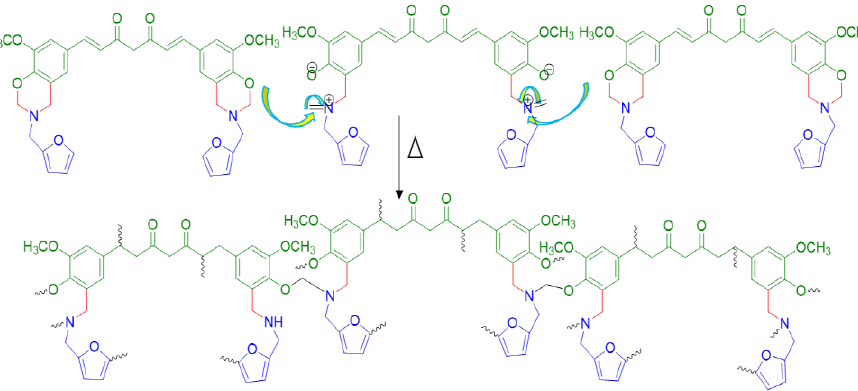
Scheme 3. Thermally induced ring-opening polymerization of benzoxazine.